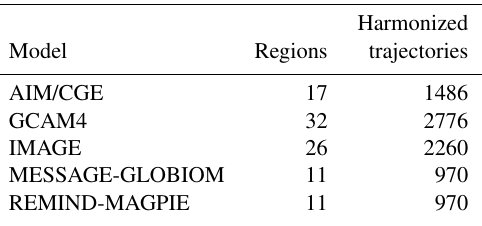
Table 3. The number of model regions and total harmonized emis- sions trajectories for each IAM participating in the study. The num- ber of trajectories is calculated from Table 2, including gas species for which global trajectories are